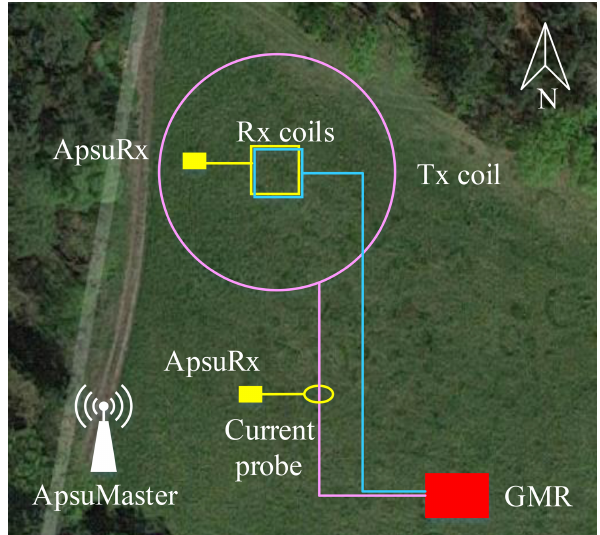
Figure 9. Field measurement setup with Apsu and GMR at the Schillerslage test site near Hanover,